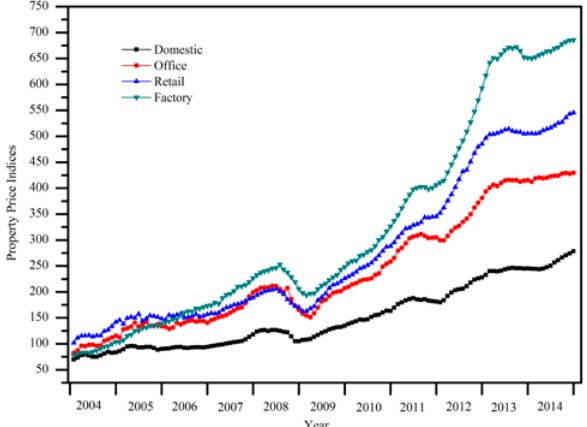
Fig. 1. Hong Kong property price index trend lines Source : Property Market Statistics, Rating and Valuation Department of Hong